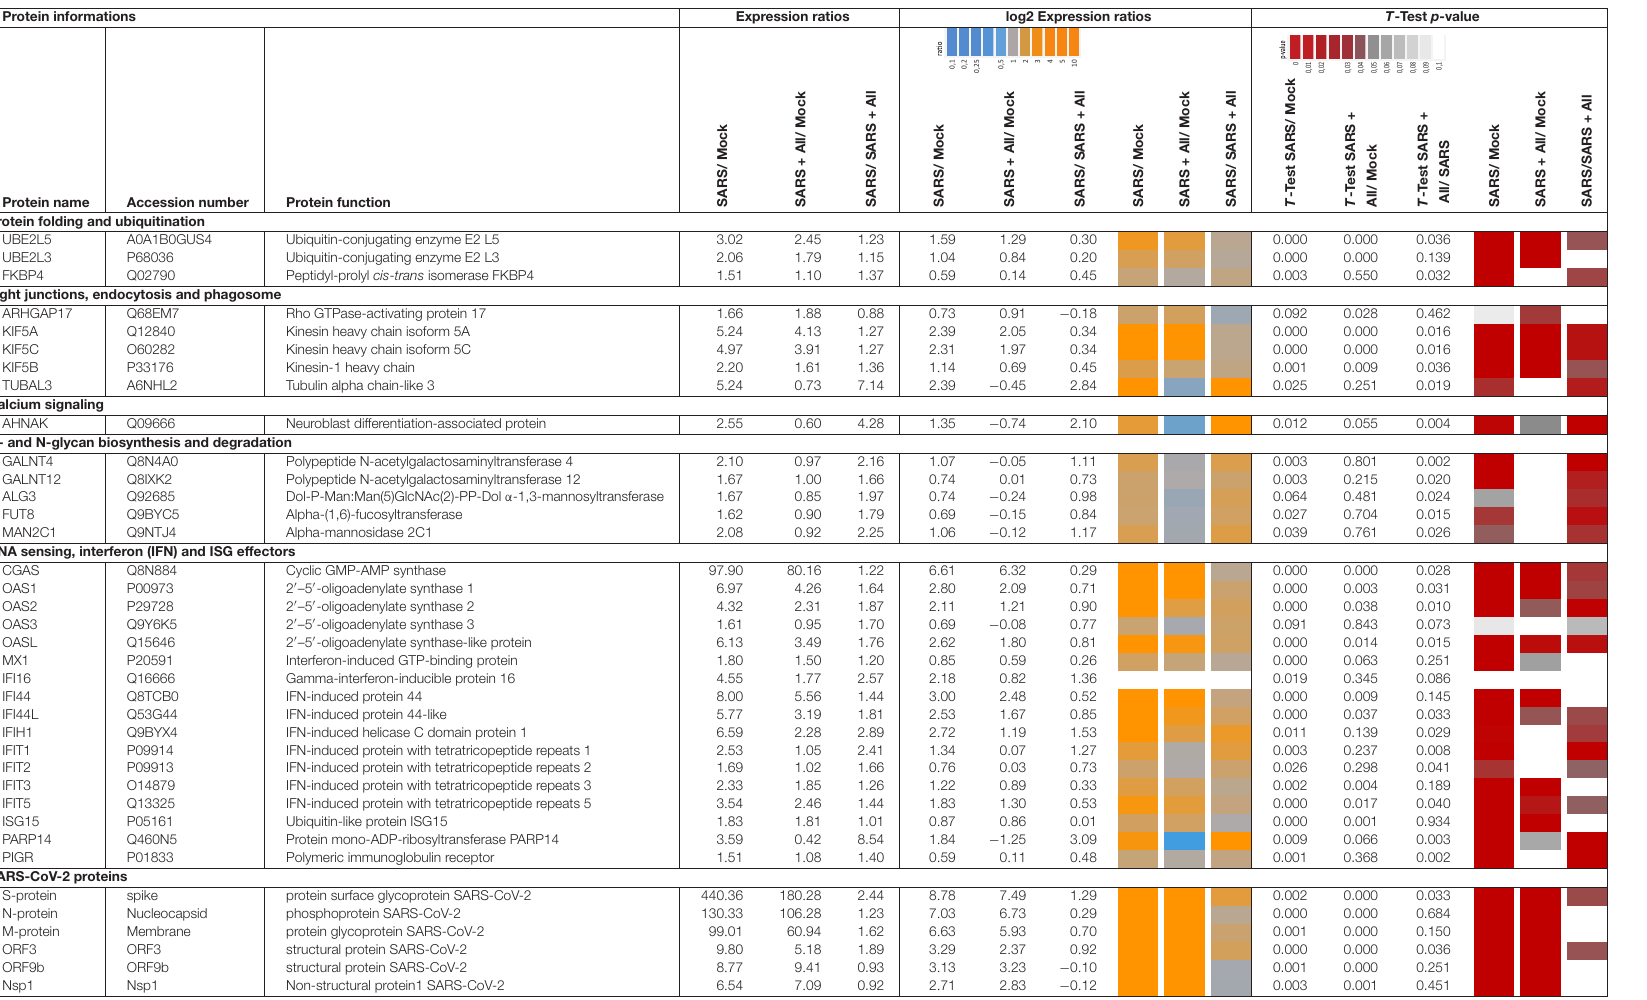
table lists 37 out of 207 identified proteins with > 1.5-fold induction upon SARS-CoV-2 infection. These proteins are most strongly induced after SARS-CoV-2 infection, affected by allicin treatment and/or are present at high abundance in the Calu-3 proteome. The proteins were classified according to their KEGG ontologies and UniprotKB annotations. The full set of up- and downregulated proteins after SARS-CoV-2 infection is listed in Supplementary Table 3 . The table includes protein names, accession numbers, protein functions, expression ratios, log2 expression ratios and p-values. The log2 ratios and p-values are visualized with a blue-orange and red-gray color code, respectively. p-values were calculated using an unpaired two-tailed t-test for two samples with unequal